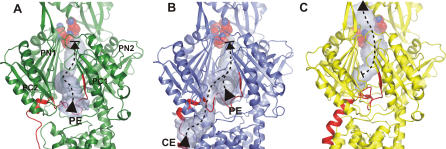
The Extension of the Channels in the Individual Subunits of AcrBThe view is the same as in Figure 2A. For simplicity, the DARPins are not shown. The channels are colored in transparent blue. The potential export pathway is represented by dashed lines. The loop forming the bottom of the periplasmic channel entrance (PE) and TM helix 8 are highlighted in red. The gate to the central funnel formed by the residues Gln124, Gln125, and Tyr758 is shown in space filling representation for clarity.(A) In subunit A, the channel is opened to the periplasm, while the gate is in the closed conformation. The pore domain subdomains are labeled.(B) In subunit B, the channel displays an open conformation to the periplasm and to the membrane bilayer (CE). The gate is in a closed conformation.(C) Subunit C displays a closed conformation of the channel entrances, while the gate is open, extending the channel to the central funnel.